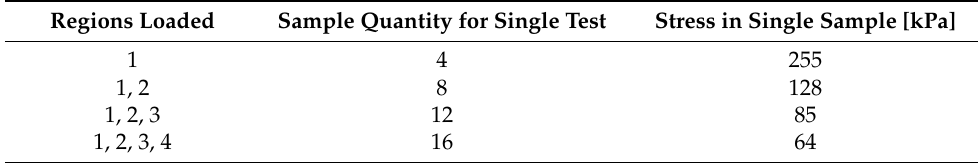
Table 3. Set of regions loaded and sample quantity with pressure applied to a single sample. Regions Loaded